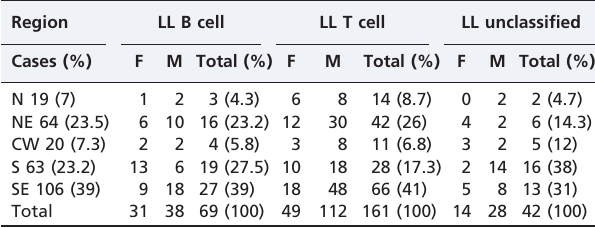
Table 3 - Precursor lymphoid neoplasms in pediatric patients classified according to cell lineage, gender, and geographical region distribution for each lineage